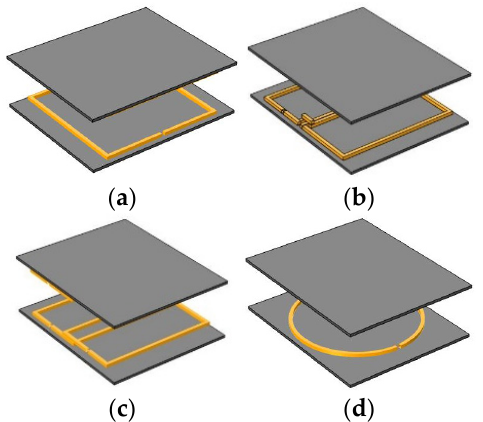
Figure 8. Coupler forms ( a ) Rec–Rec, ( b ) DD–DD, ( c ) BP–BP, ( d ) Circ–Circ.